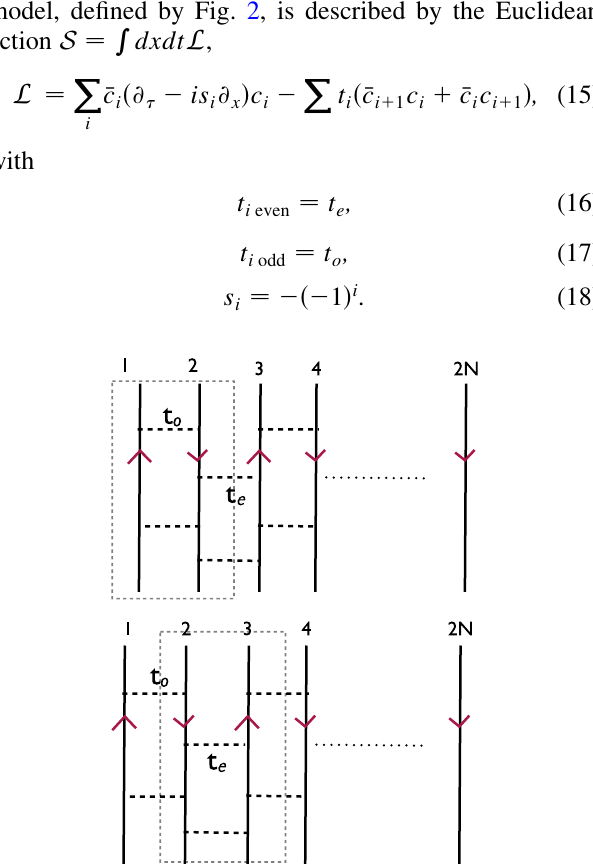
FIG. 2. Network model for the fermion IQHE transition. On the top, all chiral edge modes are paired to yield an ordinary insulator. On the bottom, there is an unpaired edge mode to yield an integer quantum Hall insulator.